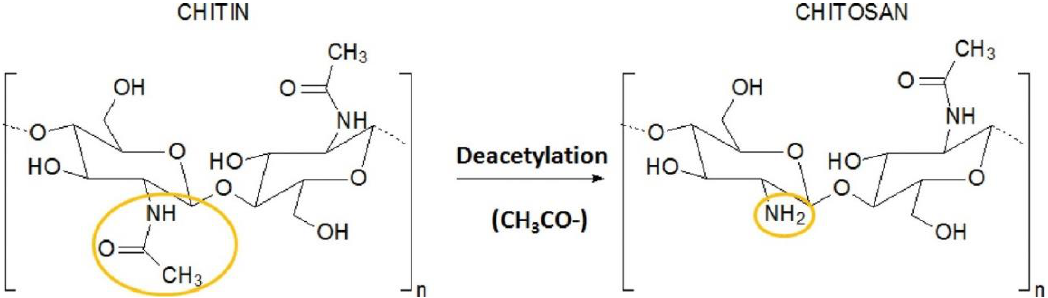
Figure 6. Diagrammatic sketch of the chemical structure of chitin and CS. Reprinted with permission from ref [139] 2017 Elsevier